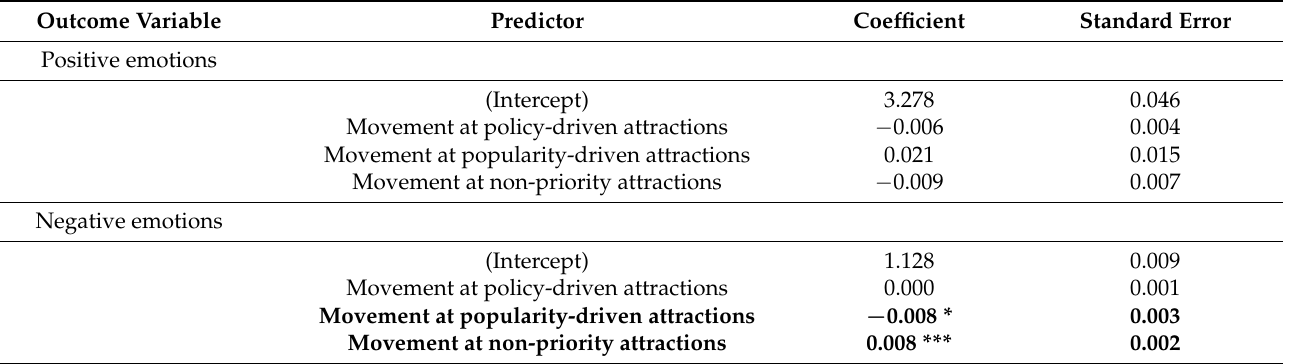
Table 4. Effects of movement at attractions compared to movement at non-attraction locations on daily